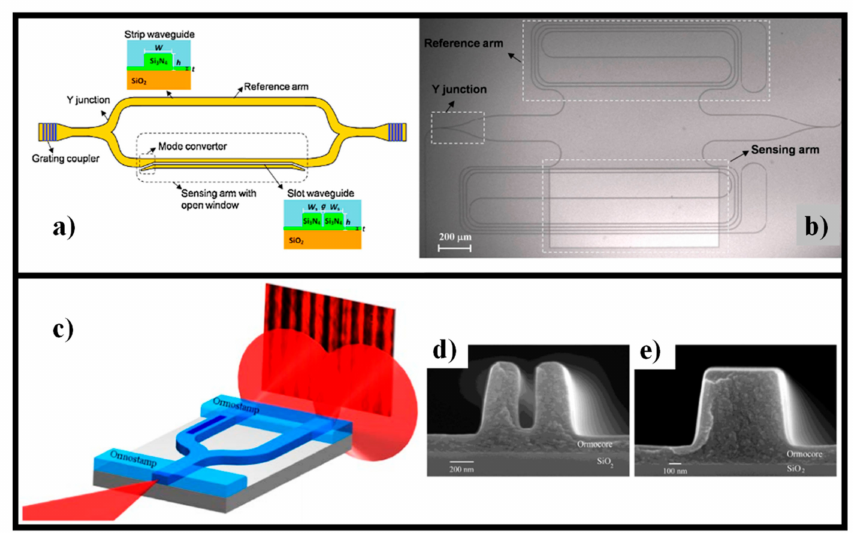
Figure 2. Biosensors based on slot WG configuration: ( a ) graphical representation of the slot-WG- based Mach–Zehnder interferometer (MZI) biosensor consisting of a reference arm and a sensing arm joined with two Y-junctions. Reprinted with permission from ref. [24]; ( b ) microscopic image of the fabricated MZI biosensor. Reprinted with permission from ref. [24]; ( c ) graphical illustration of the slot YI and the measurement setup; ( d ) SEM picture of the cross-section of the slot WG. Reprinted from ref. [32]; ( e ) SEM picture of the cross-section of the reference ridge WG. Reprinted from ref.